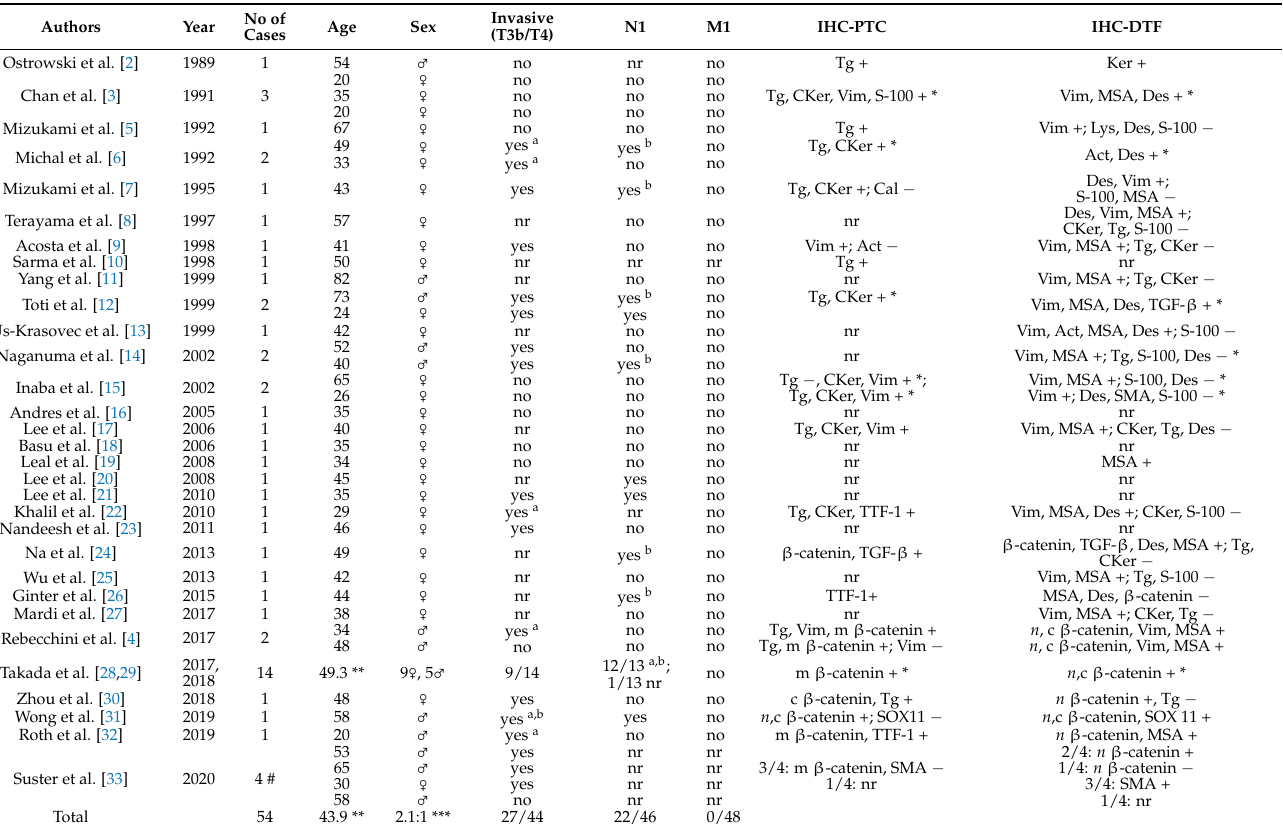
Table 1. Reported cases of